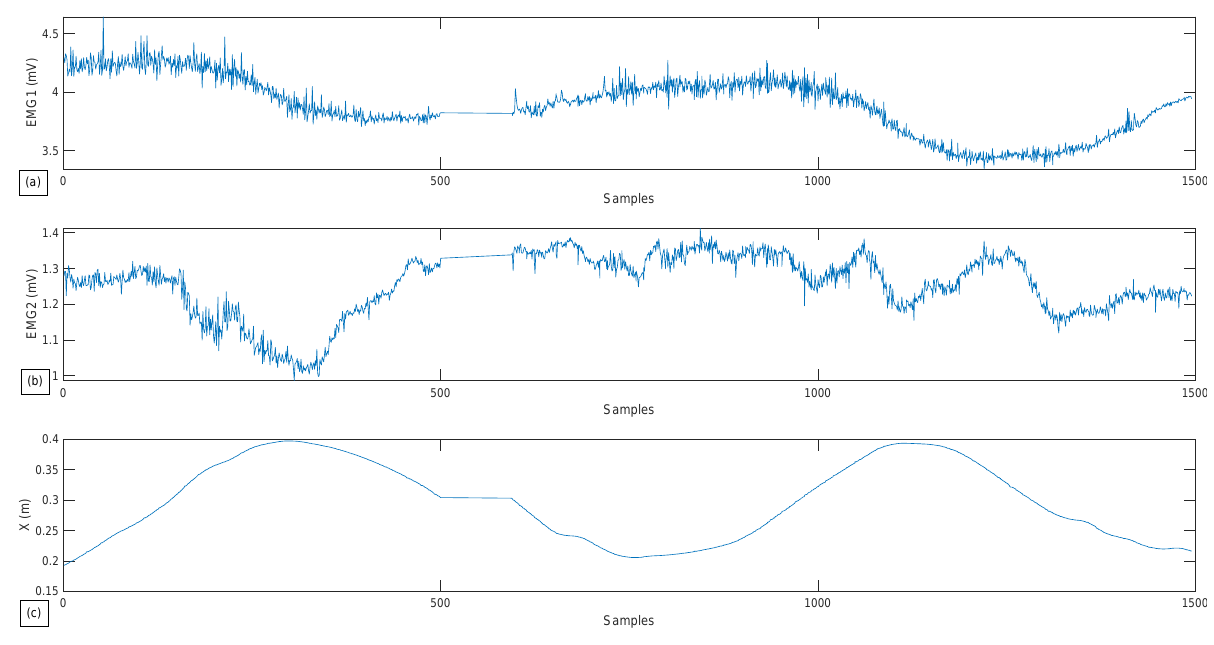
Figure 14. Experimental test for a free Active-Assisted lateral shoulder rotation. ( a ) Muscle activity for the Deltoid muscle. ( b ) Muscle activity for the Latissimus Dorsi. ( c ) Robot position in x in relation to the